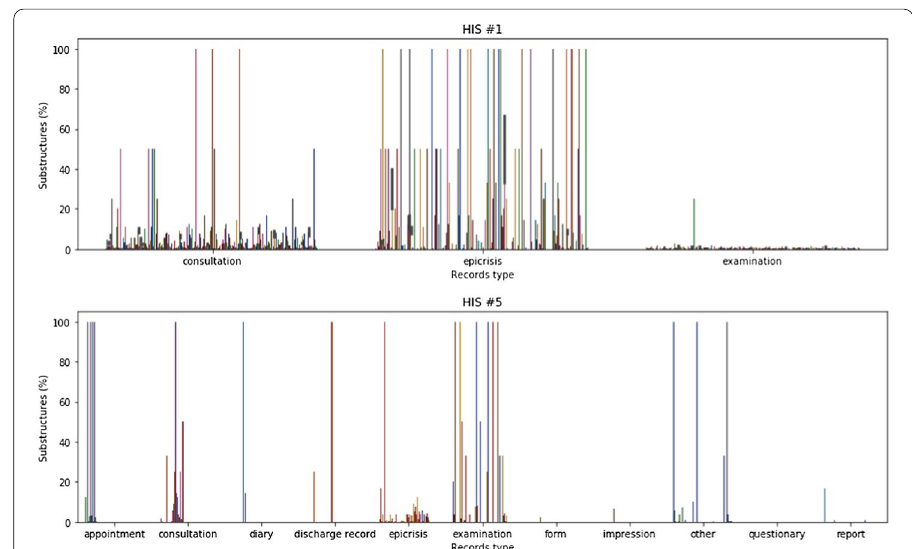
Fig. 13 Percentage distibutions of subsections among records type for HIS #1 and HIS #5 (different colors for different subsections)